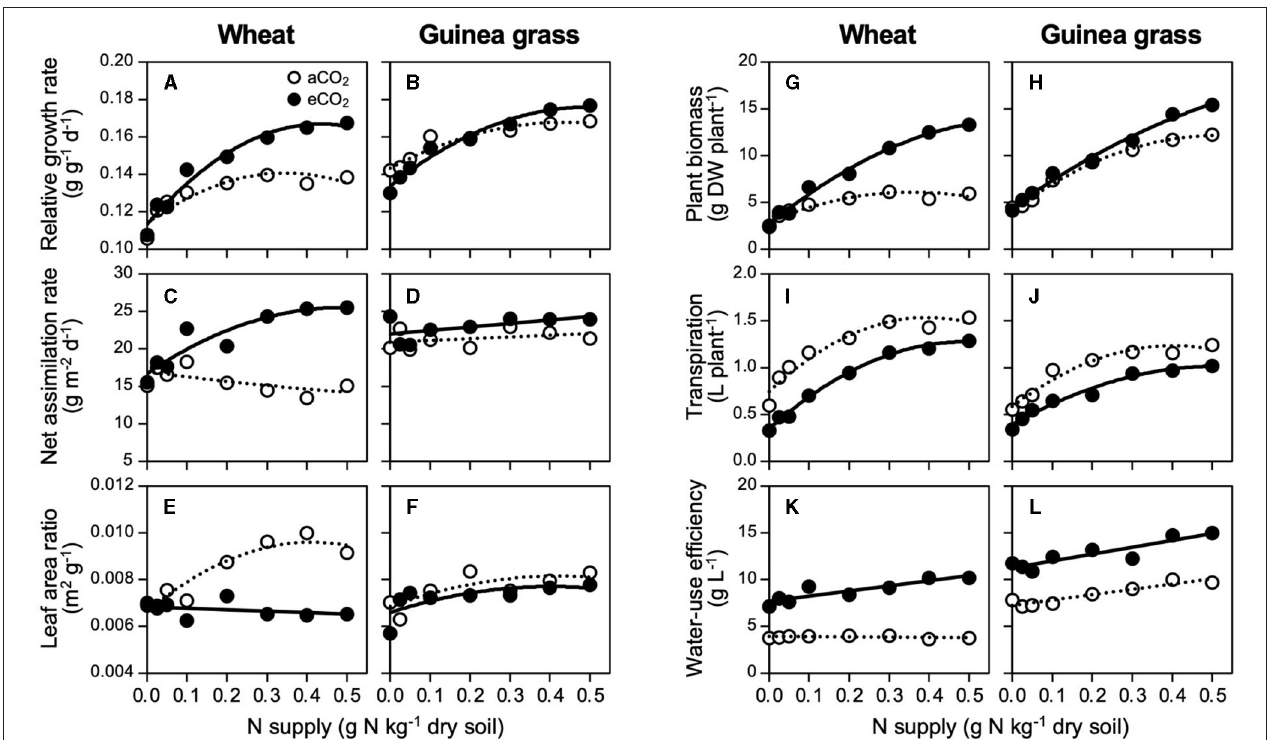
FIGURE 2 | Growth responses for nitrate-N supply in C 3 wheat and C 4 guinea grass is grown for 28 d in the chambers under ambient (aCO 2 ) or elevated (eCO 2 ) CO 2 treatments. Relative growth rate (A,B) , net assimilation rate (C,D) , leaf area ratio (E,F) , plant biomass (G,H) , cumulative transpiration (I,J) , and water-use efficiency (K,L)